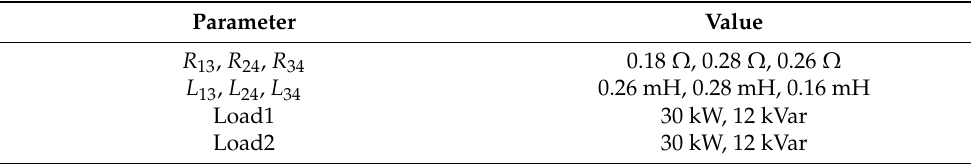
Table 2. Electrical parameters.